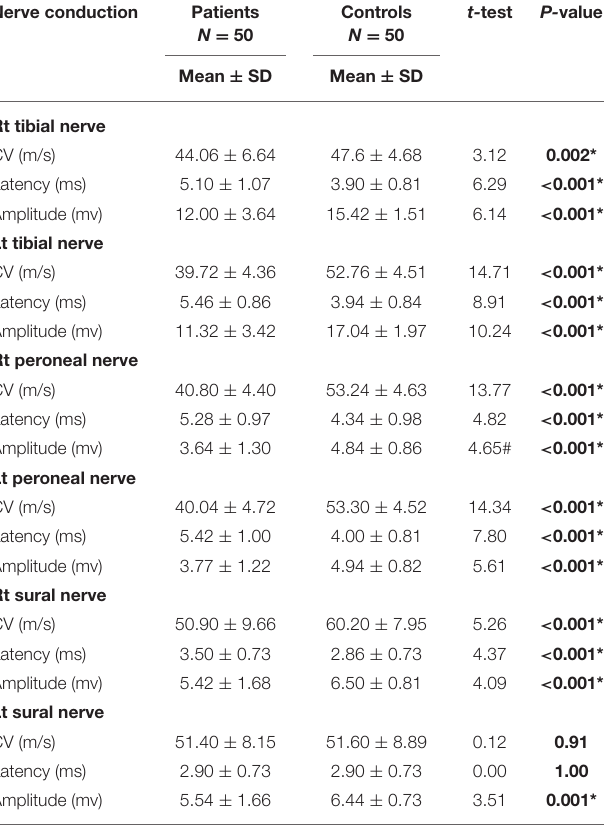
TABLE 2 | Nerve conduction findings among patients and controls. Nerve conduction